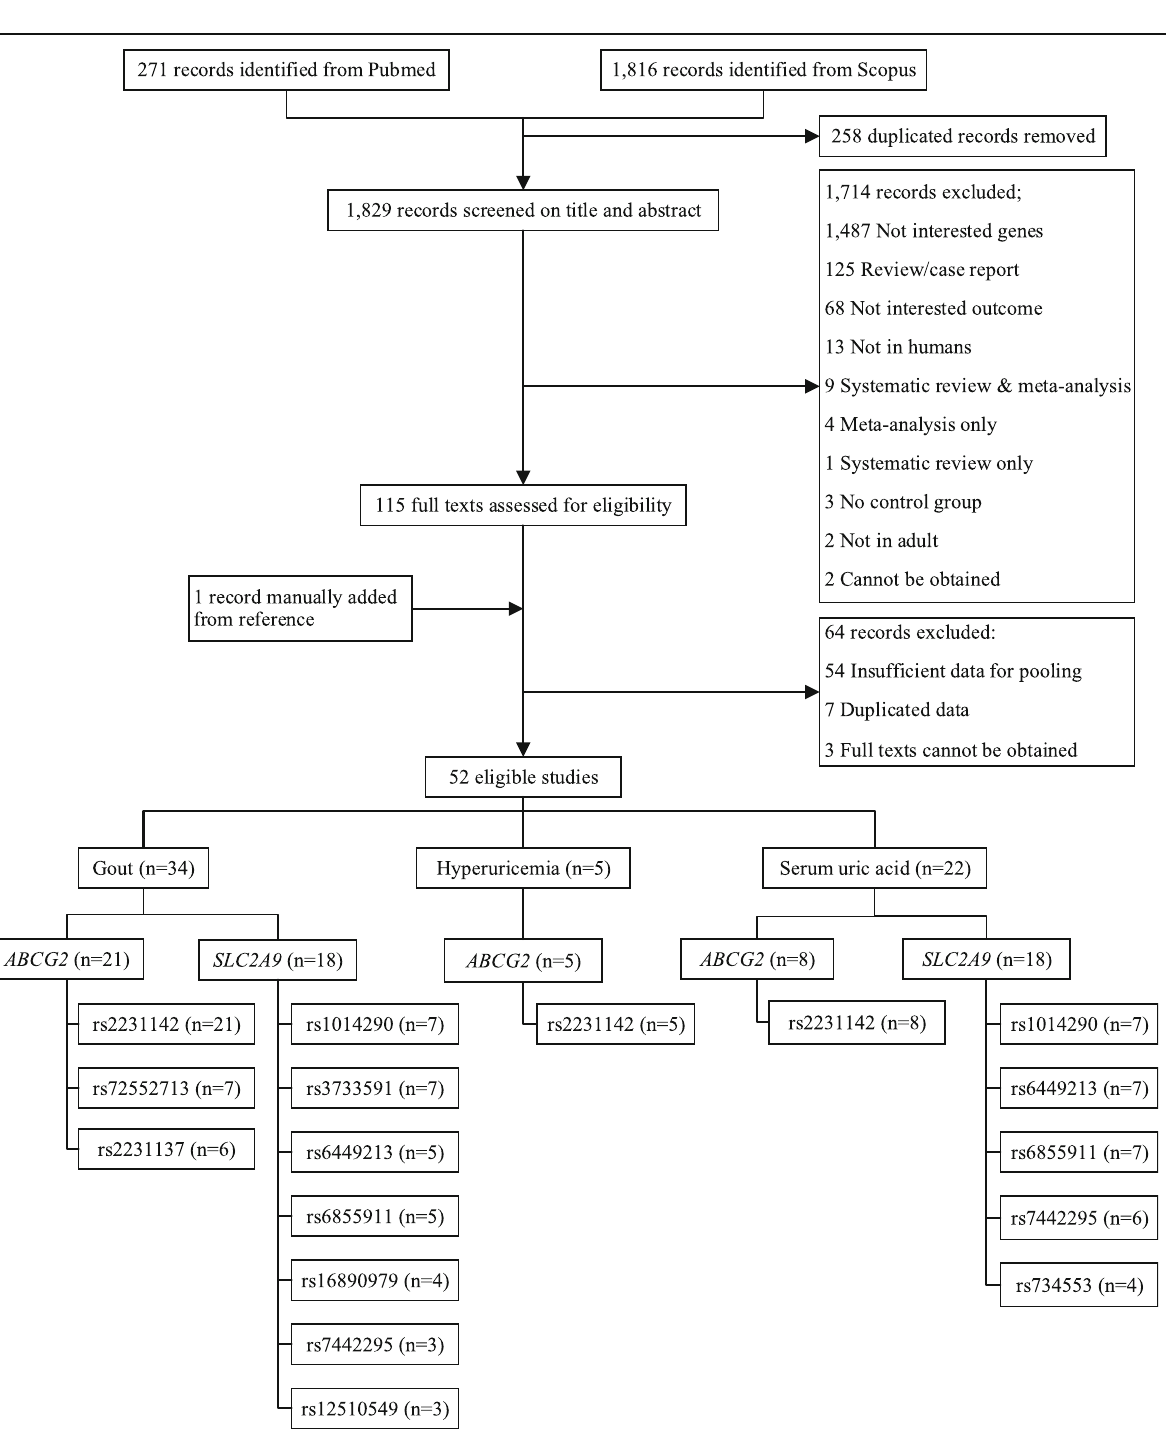
Fig. 1 Flow for identifying and selecting studies. ABCG2 , ATP-binding cassette sub-family G member 2; SLC2A 9, solute carrier family 2 member